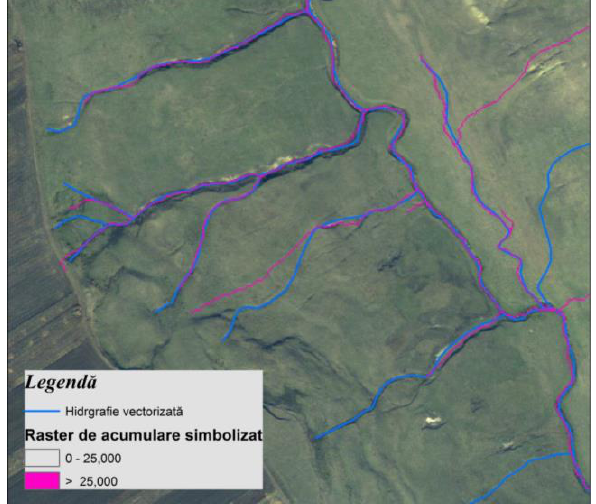
Figure 2. Comparison between the water courses generated by LiDAR data and the courses verctorized on the ortho photo For the example presented above the raw Lidar data had a mean spatial resolution of 0.5m. In this case the results are optimal as a primary or secondary data source for the updating of the 1:5000 scale